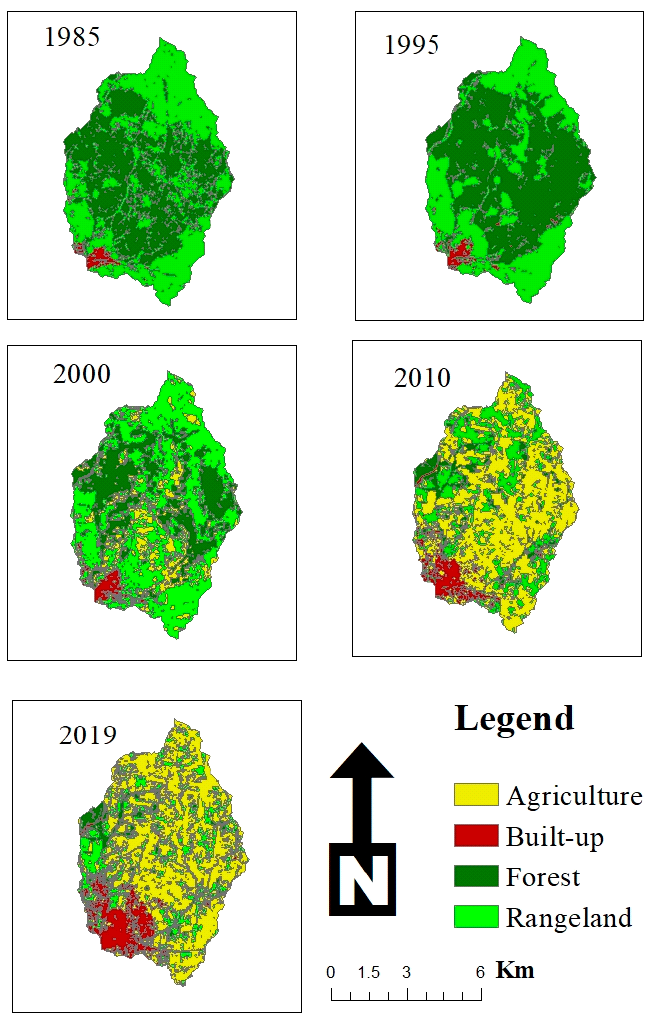
Figure 4. Classified land use land cover maps of Kakia and Esamburmbur sub-catchments of Enkale Narok watershed for 1985, 1995, 2000, 2010, 2019.